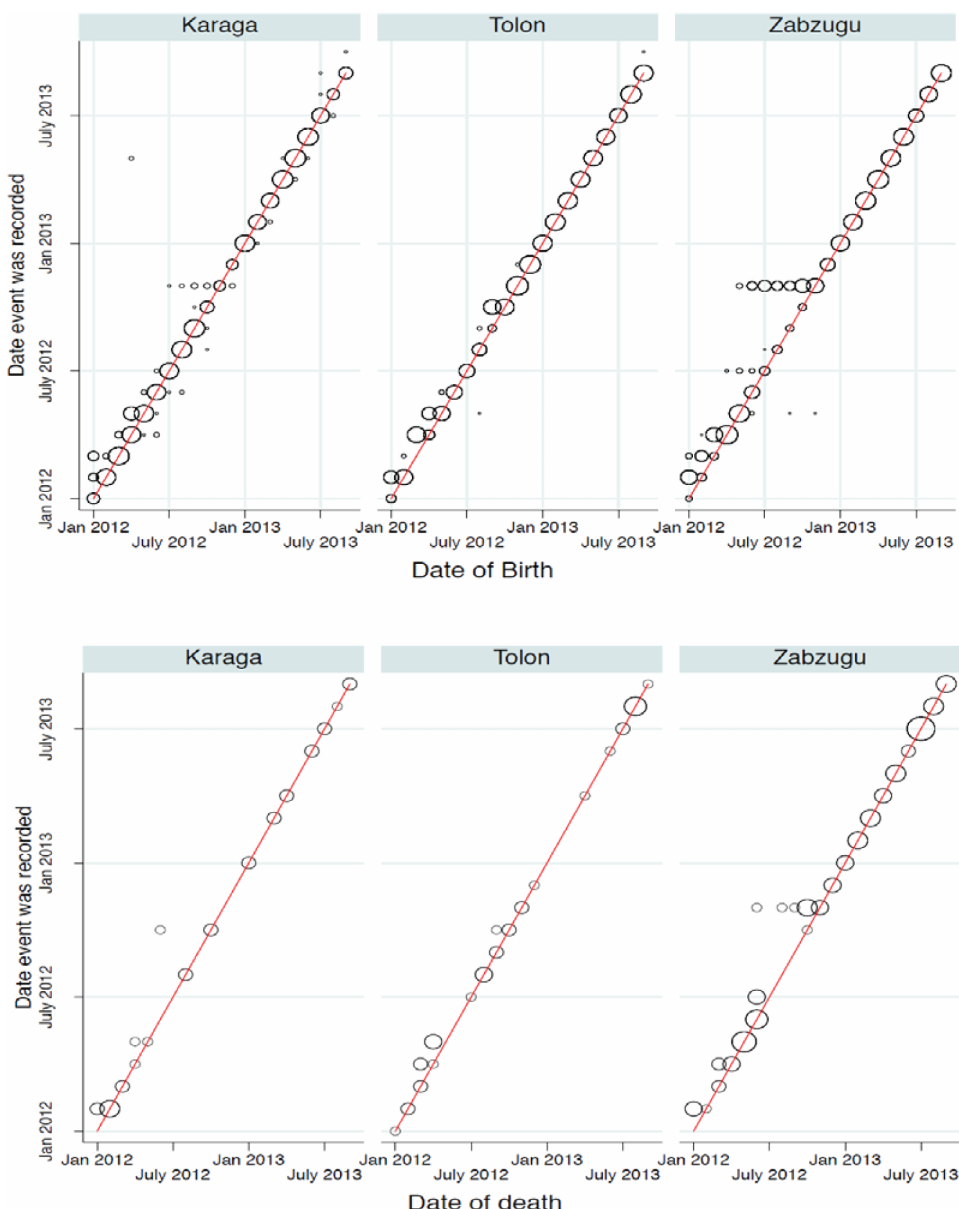
Fig 1. Reporting delays in CBV data. Panel a: delays in reporting of births. Panel b: delays in reporting of deaths, by district. Notes : each circle represents the number of events having occurred during month x and being recorded during month y . The size of each circle is proportional to the number of such events . The red line represents the absence of reporting delays , i . e ., x = y . Circles above the red line represent events reported with delays , whereas circles below the red line represent events that were reported before they occurred (i . e ., possible data entry errors)